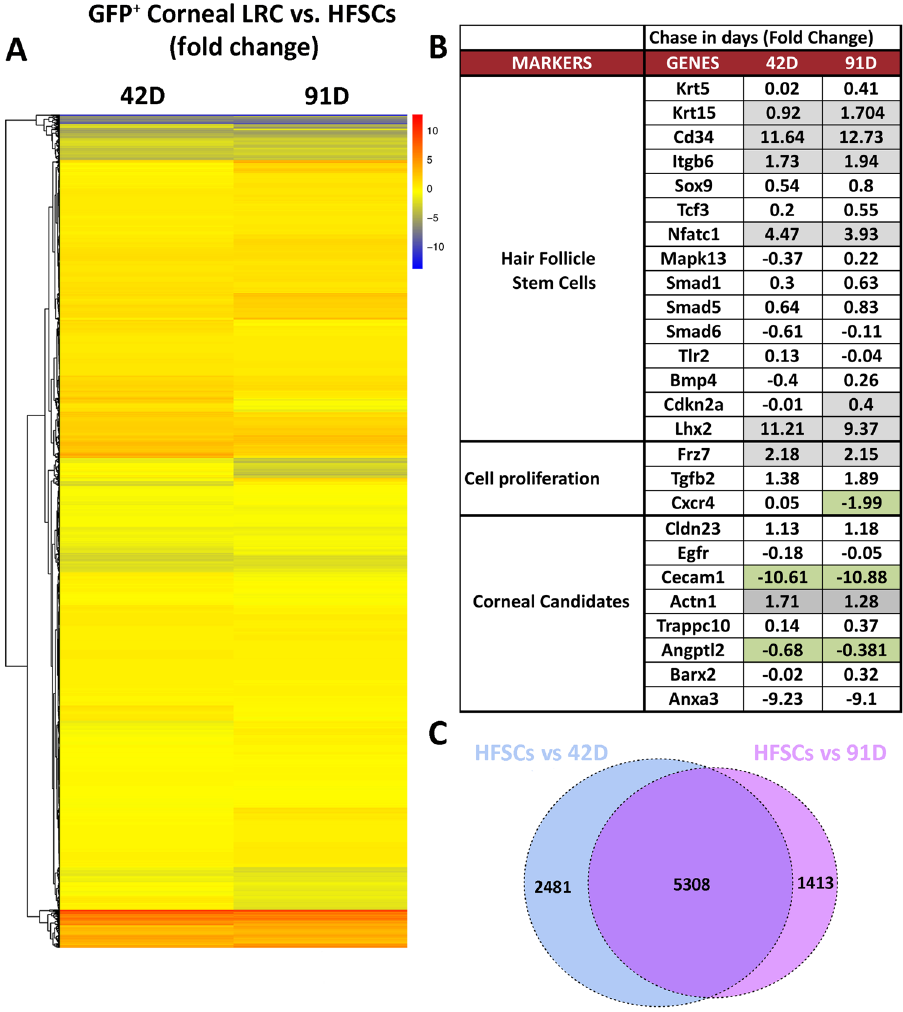
Figure 4. RNA-Seq analysis between hair follicle stem cells (HFSCs) and corneal GFP + LRCs show markedly high similarity in gene expression. ( A ) Heatmap comparing RNA-Seq expression of GFP + LRCs at 42 d chase (left, n = 3) and 91 d chase (right, n = 5) to CD34 + HFSCs gene expression (Kadaja et al . 13 ). Blue indicates lowest expression while red means high expression in GFP + cornea LRCs. The heatmap includes 9202 genes showing a high similarity in gene expression between the corneal GFP + LRCs versus HFSCs as indicated by the lack of color change. ( B ) Comparison of expression levels for genes involved in HFSC stemness, cell proliferation and corneal candidates. Boxes highlighted in green indicates significant expression in GFP + LRCs of the cornea; those highlighted in grey, show significance expression in the skin and no color indicates no significance difference between HFSCs and GFP + LRC selected genes. ( C ) Venn diagram showing 5308 genes with similar expression levels between HFSCs and GFP + LRCs of the cornea at 42 and 91 d chase periods. The diagram also shows that 2481 genes are differentially expressed between HFSCs and 42 d chase (blue) and 1413 genes are solely differentially expressed between HFSCs and 91 d chase